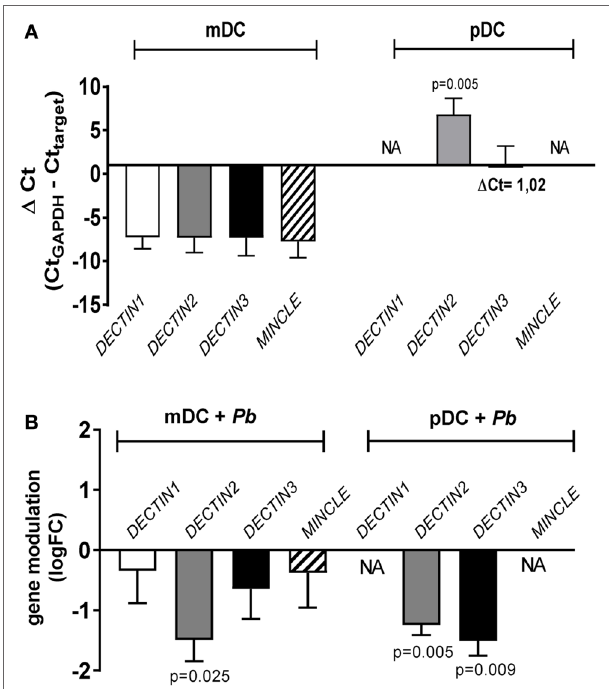
FigUre 8 | DECTIN1/2/3 and MINCLE gene expression in myeloid dendritic cell (mDC) and plasmacytoid dendritic cell (pDC) stimulated with Paracoccidioides brasiliensis . mDCs and pDCs from four healthy individuals were either left unstimulated or challenged overnight with P. brasiliensis yeast cells. Then RNA was isolated from each condition and used to evaluate the expression of DECTIN1/2/3 and MINCLE genes by qPCR. GAPDH was used as housekeeping gene for raw data normalization. (a) Basal genes expression in mDC and pDC was calculated as Δ Ct ( Δ Ct = Ct GAPDH − Ct target ) as previously reported (31). Data are represented as mean ( Δ Ct) ± SE. Kruskal–Wallis test was applied to verify the significance of the difference between basal gene expression in mDC and pDC. When significant, the Δ Ct of mDC versus pDC genes is indicated at the top of each bar ( p ). NA, not amplified. (B) The modulation of expression by P. brasiliensis was (20) calculated using the 2 −ΔΔ Ct (fold-change, FC) method comparing stimulated and unstimulated cells ( ΔΔ Ct = Δ CtPb − Δ CtUnstimulated). Data are represented as mean (logFC) ± SE. Student’s t -test was applied to verify the significance of the FC. When significant, the fold-change of stimulated versus unstimulated cells is indicated at the top of each bar ( p